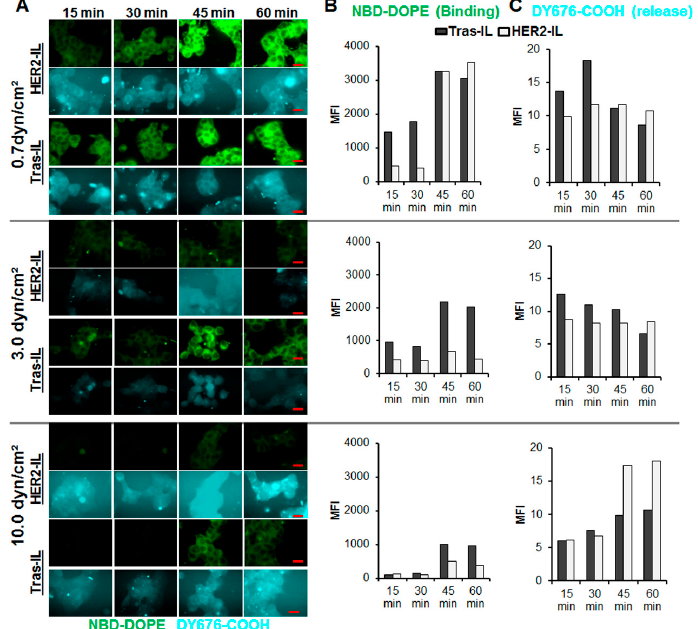
Figure 5. Validation of the interaction and cargo-release of HER2-targeting liposomes in HER2 expressing BT-474 cells under dynamic flow conditions. The HER2’scFv-bearing liposome, HER2-IL and a liposomal formulation bearing the HER2-specific humanized therapeutic antibody, trastuzumab (Tras-IL) were added to culture medium at 10 nmol (final lipids)/mL medium and flushed at the indicated flow rates (0.7, 3.0, and 10.0 dyn/cm 2 ) over adherently growing BT-474 at standard culture conditions. At the indicated time points 15, 30, 45, and 60 min the perfusion was stopped, cells fixed in the flow chambers and imaged on a fluorescence microscope ( A ), scale bar, 20 µm. Thereafter, the images were subjected to semiquantitation of the green fluorescent phospholipid NBD-DOPE which is indicative of binding ( B ) and the liposomal encapsulated DY676-COOH which reveals liposomal cargo release and activation ( C ).